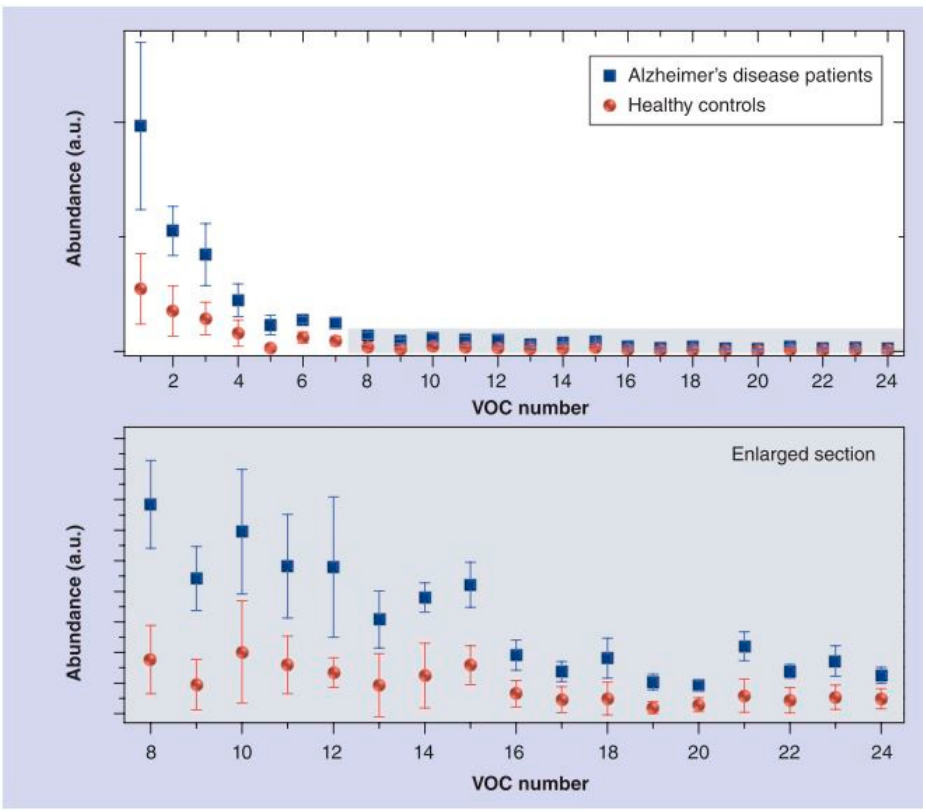
Figure 17. Gas chromatography-mass spectrometry analysis of the breath of Alzheimer’s disease patients. Abundance of 24 VOCs that were found in the breath of >80% of both the Alzheimer’s disease patients and the healthy controls. The symbols represent the average abundance and the error bars mark the borders of the 95% CIs. VOC: Volatile organic compound. Used with permission from [37].